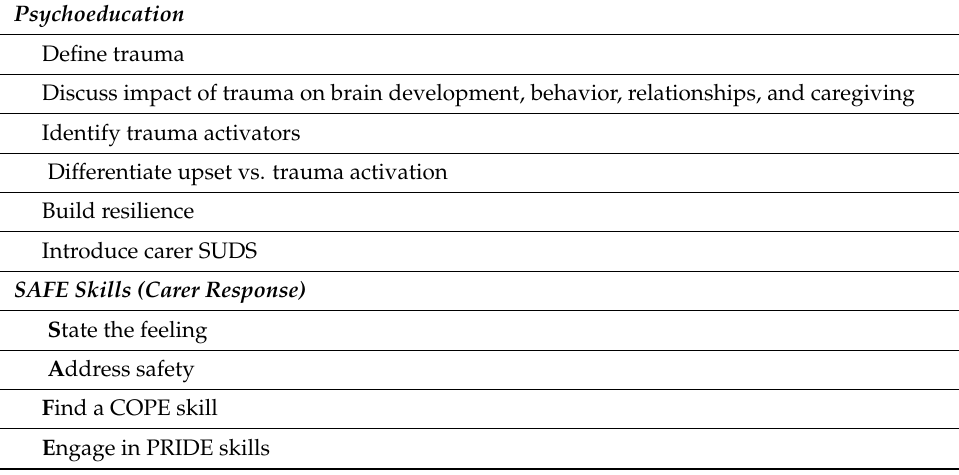
Table 2. Components introduced in TDI